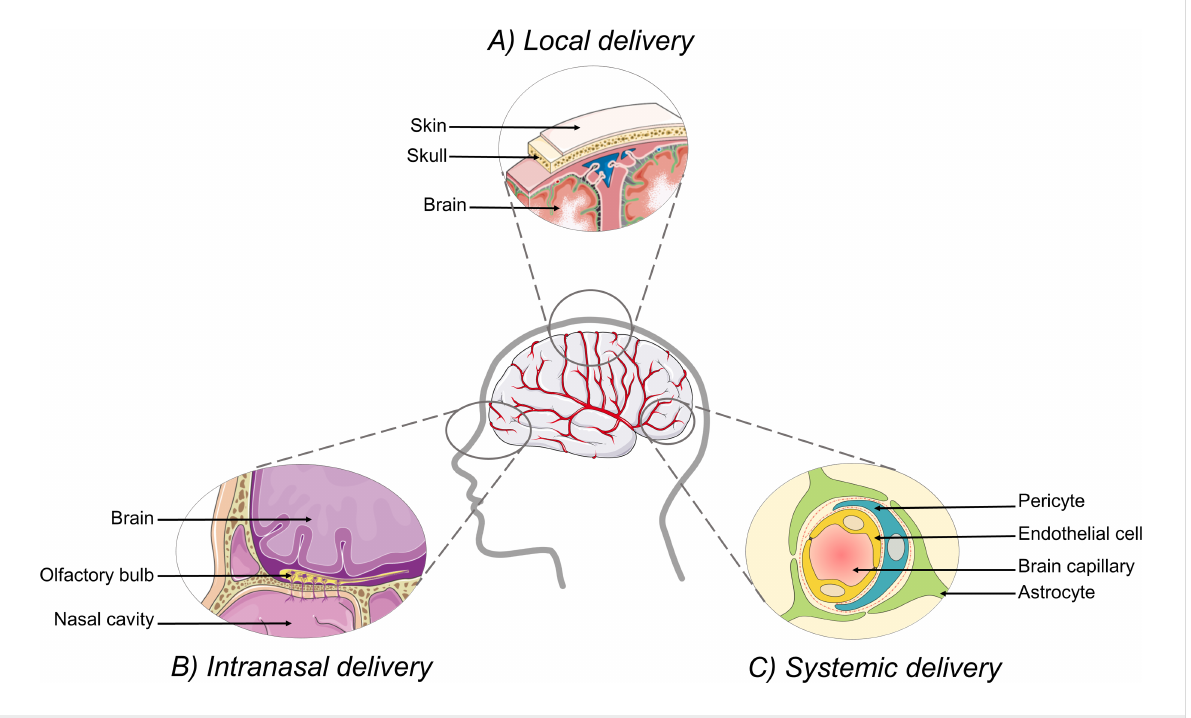
Figure 2: Brain delivery routes. A) Local delivery. Drugs can reach the brain by direct injection through the meninges. B) Intranasal delivery. Drugs can be transported to the brain via the olfactory bulb, located at the top of the nasal cavity. C) Systemic delivery. Drugs can reach the brain by crossing the blood–brain barrier (BBB) around the brain capillaries. Made using cliparts from Servier Medical Art by Servier, https://smart.servier.com/. Original cliparts are licensed under a Creative Commons Attribution 3.0 Unported License, https://creativecommons.org/licenses/by/3.0/.